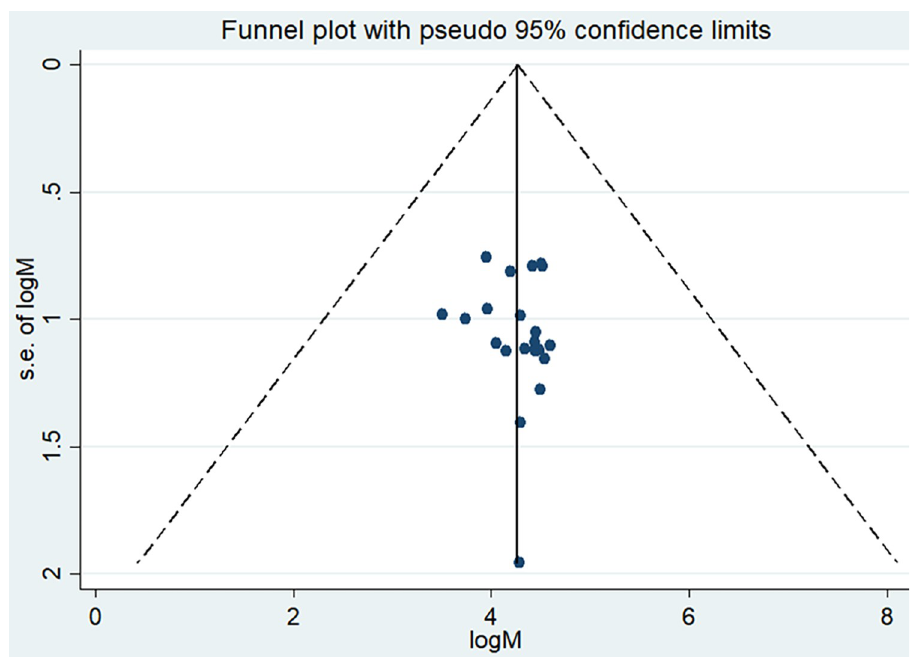
Fig 3. Funnel plot showing publication bias of magnitude of disclosing HIV status among adult HIV infected peoples, a systematic review and meta-analysis, Ethiopia, 2020.